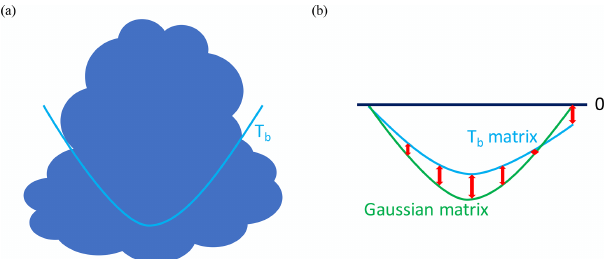
Figure 1. (a) A typical shape of a convective cloud and its T b dis- tribution around the convective core (blue line). (b) Schematic rep- resentation of distributions of the upside down Gaussian matrix (green) and the T b matrix (blue) when the cloud is